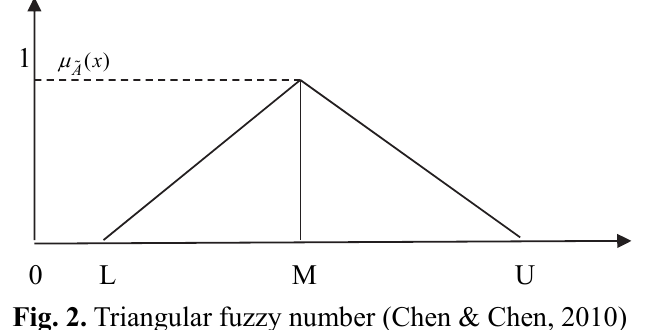
Fig. 2. Triangular fuzzy number (Chen & Chen, 2010)